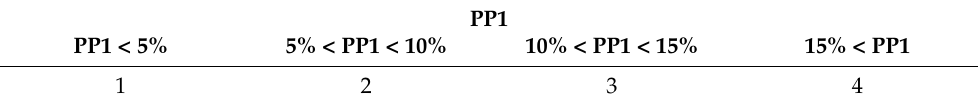
Table 8. Damage classes used for